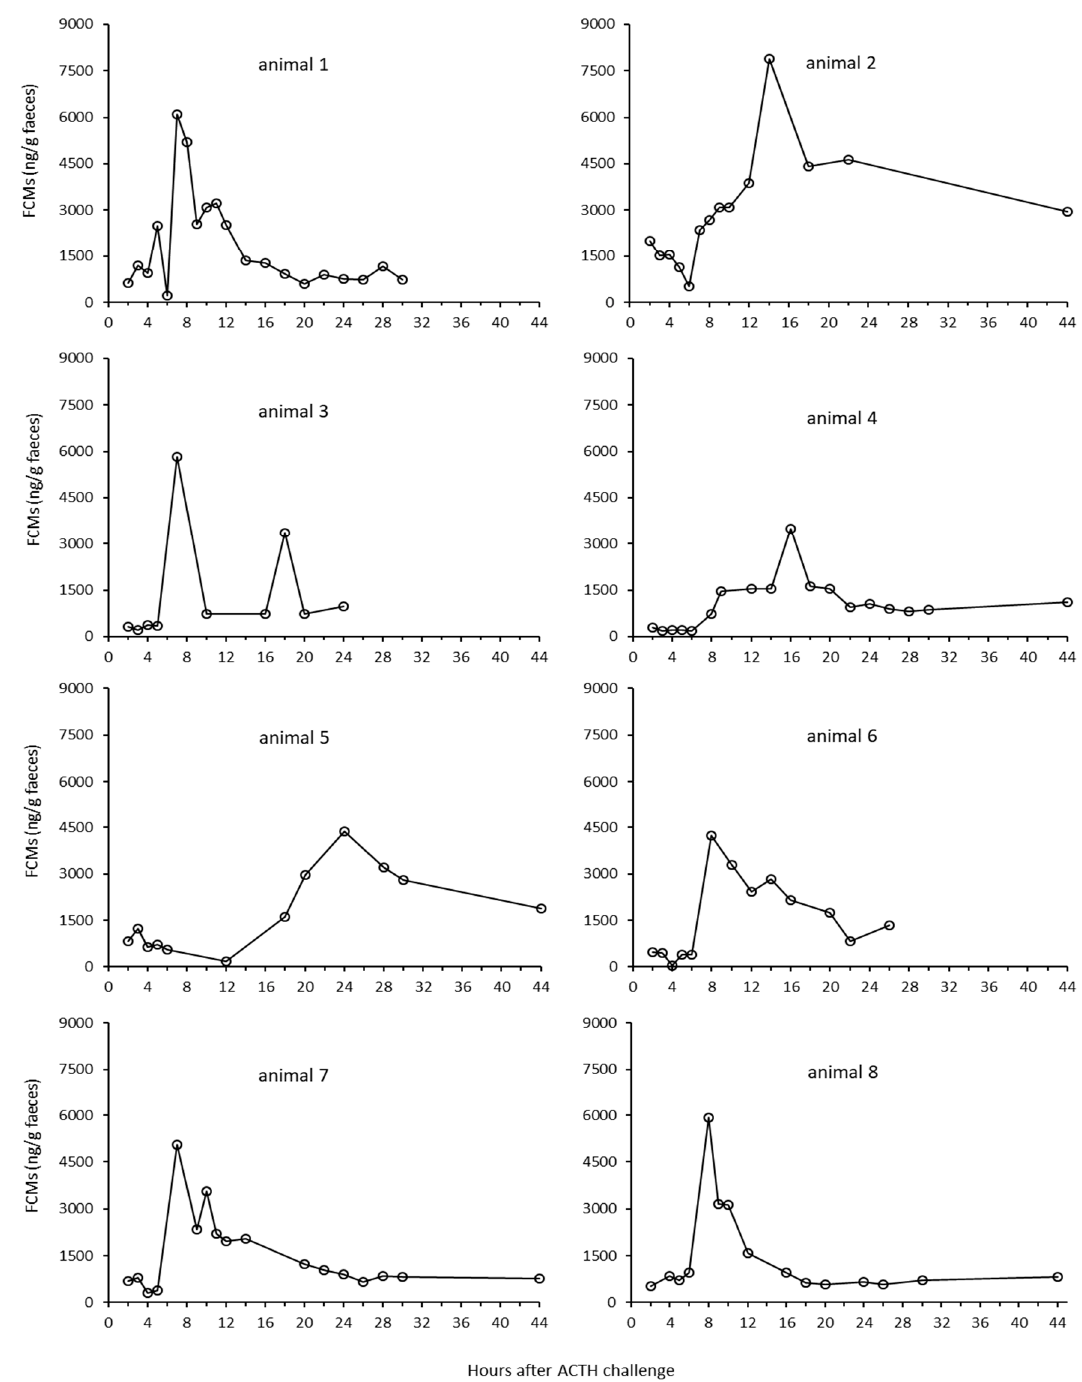
Figure 2. Concentration of faecal cortisol metabolites (FCMs) from identified samples of the eight individual animals at Tverrvatnet, shown as a function of hours after ACTH challenge.